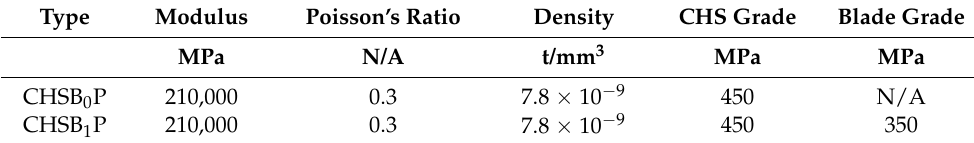
Table 3. Pile material parameter .